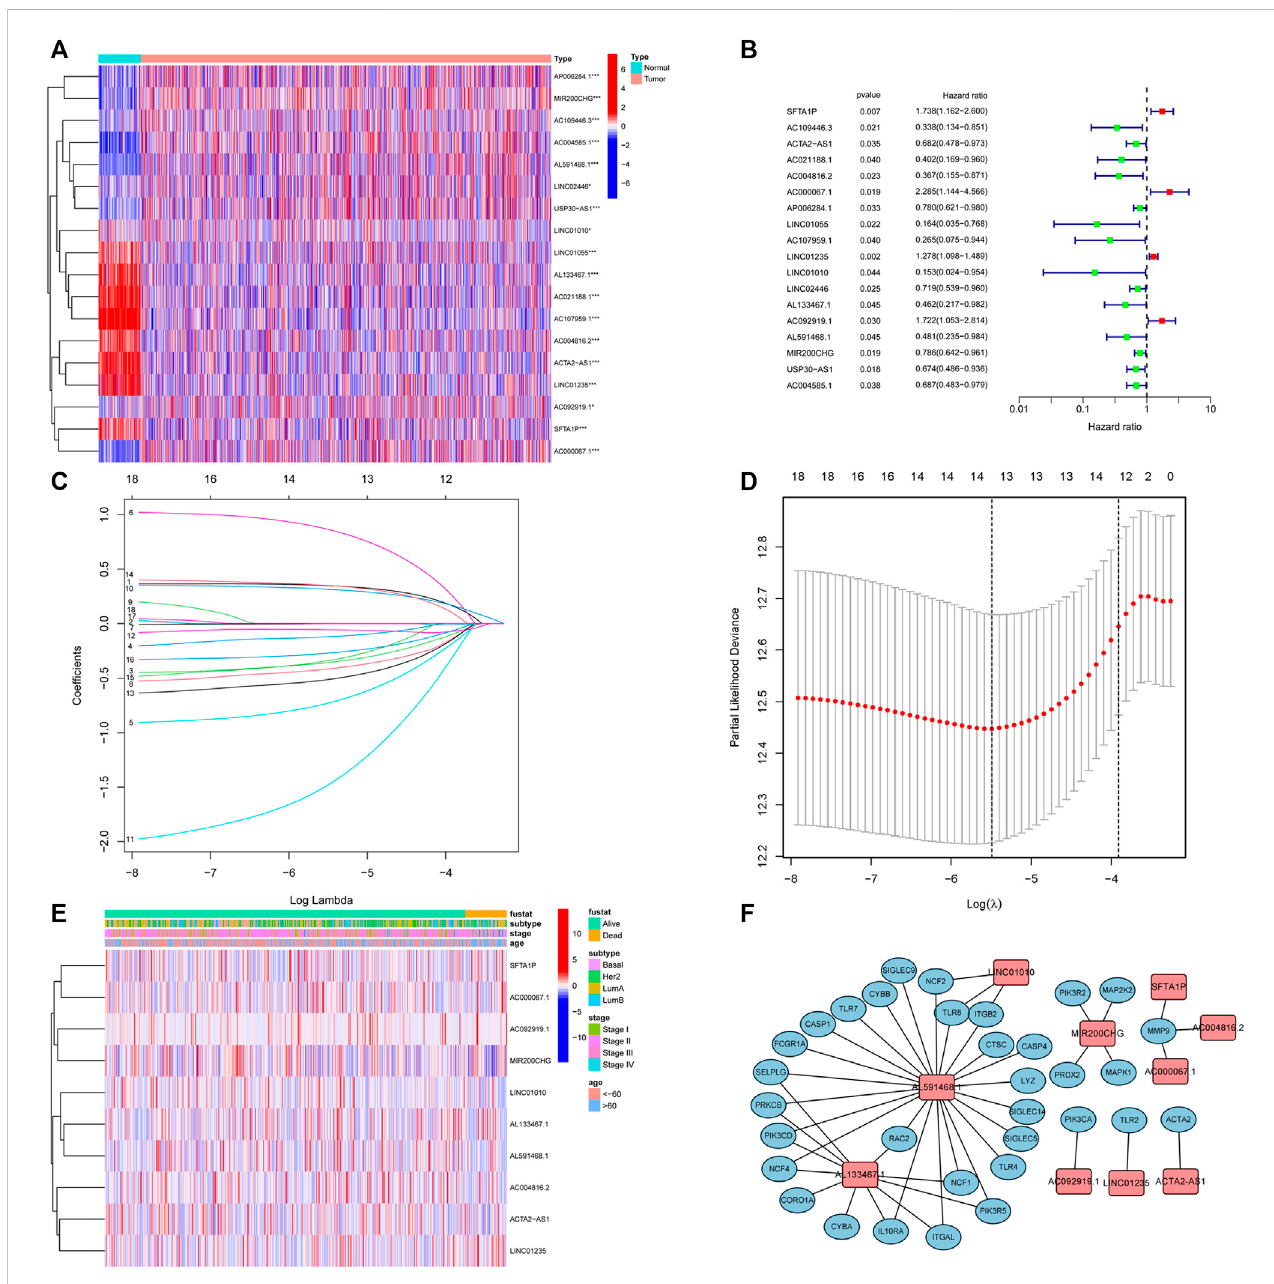
FIGURE 3 Identi fi cationofprognosticNETs-relatedlncRNAs. (A) HeatmapofOS-associateddifferentiallyexpressedNETs-relatedlncRNAs. (B) ForestplotofNETs- relatedlncRNAsassociatedwithBCprognosis via univariateanalysis. (C) LASSOcoef fi cientpro fi lesof13NETs-relatedlncRNAs. (D) Cross-validationfortuning parameter selection in the proportional hazards model. (E) Heatmap of the 10 NETs-related lncRNAs via multivariate analysis. (F) Correlation between 10 NETs-related lncRNAs and NETs genes. NETs, neutrophil extracellular traps; lncRNAs, long non-coding RNAs; BC, breast cancer; OS, overall